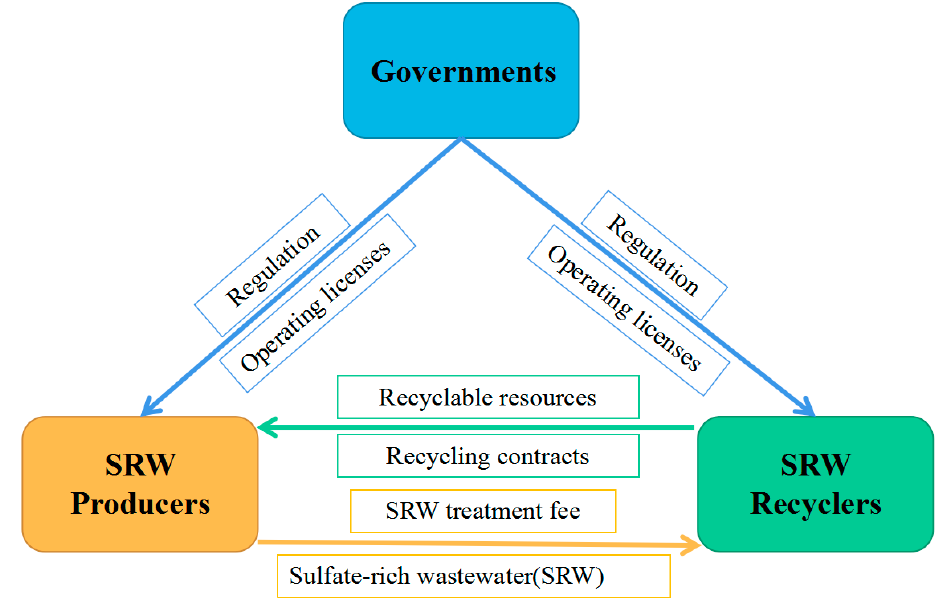
Figure 1. Relationship among the participants in sulfate-rich wastewater (SRW) management. Based on the above analysis of the dynamic interplay between the three parties, we have formulated the following assumptions. Table 1 presents the definition of the parameters implicated in